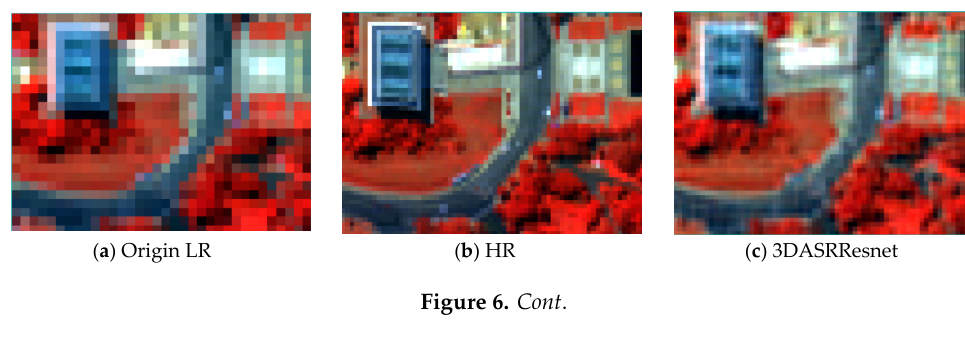
Figure 5. Results of various SR HSI methods and original low-resolution (LR) and high-resolution (HR) images based on Washington DC Mall dataset.